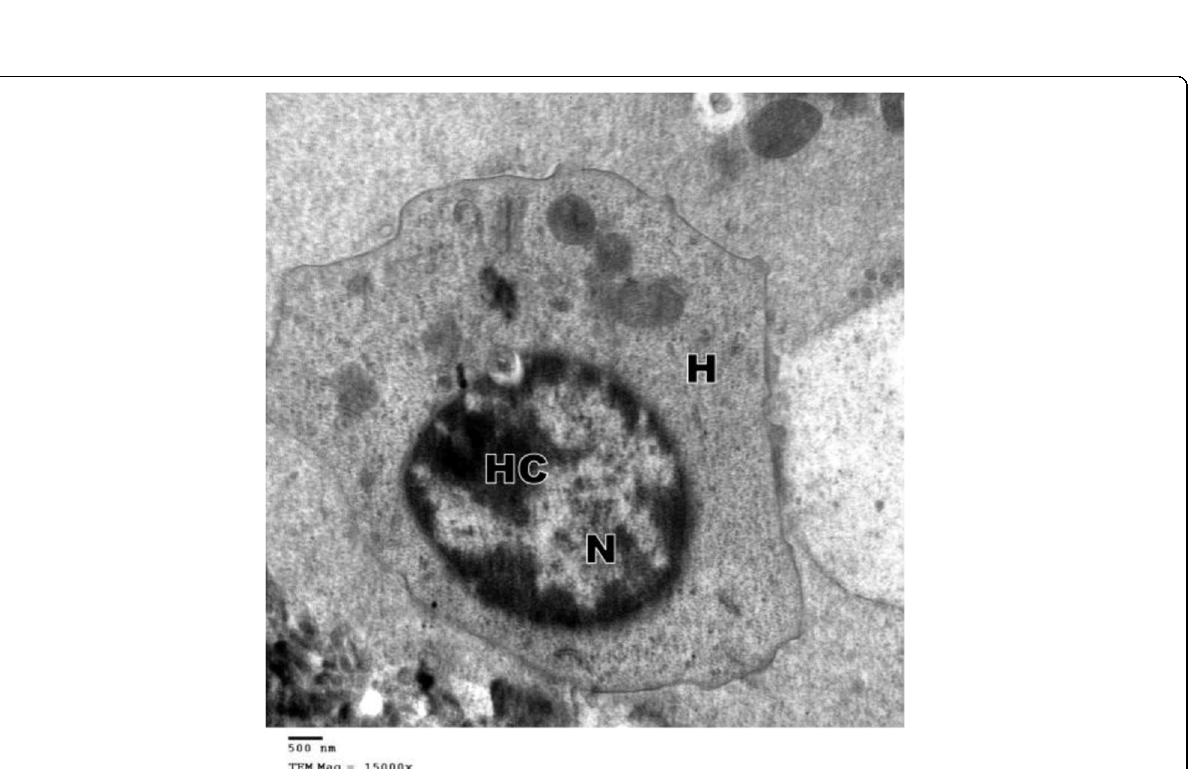
Fig. 17 An electron micrograph of a hepatocyte of treated mouse with Tamiflu (16 mg/kg b.wt.) for 10 days revealing many lysosomes (Ly), mitochondria (M), and Kupffer cell (KC) in sinusoid (S). (× 8000)